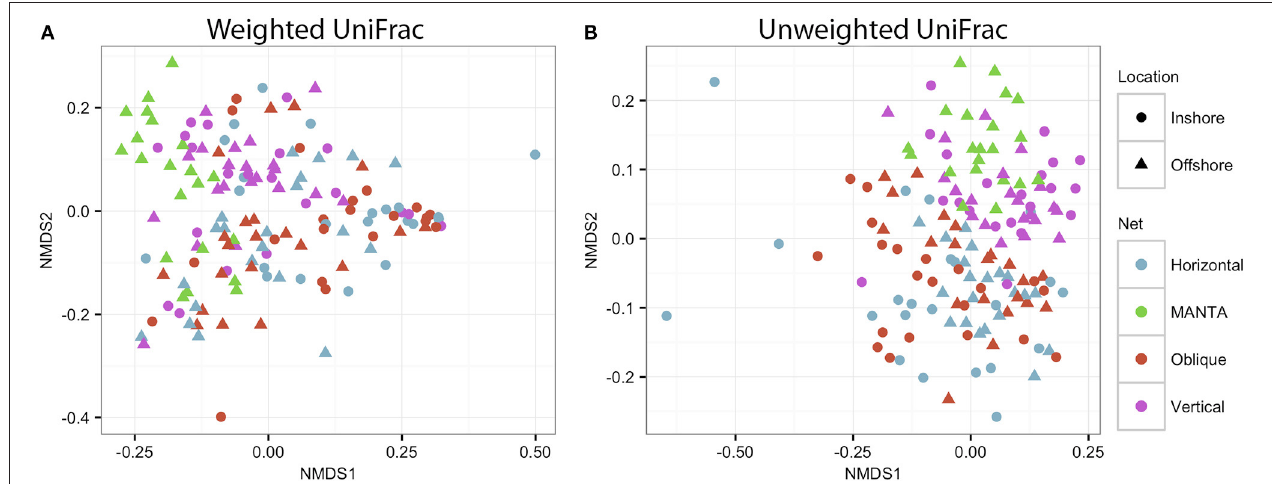
FIGURE 6 | NMDS plot based on (A) weighted and unweighted (B) UniFrac distance matrices showing clustering of the four different sampling methodologies for both the inshore and offshore stations in the central Red